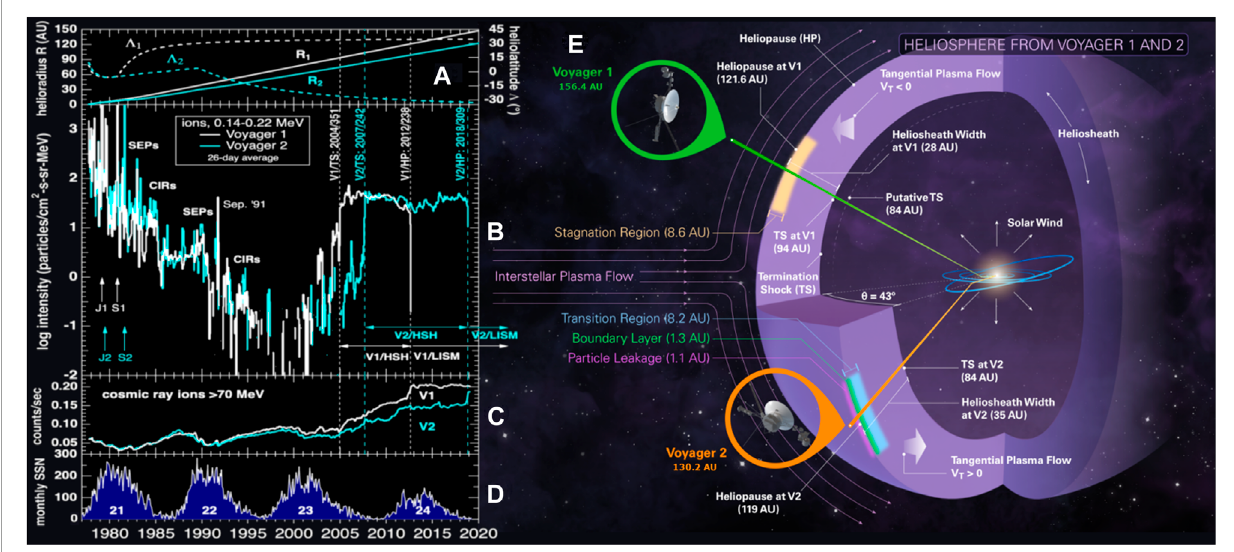
FIGURE 1 (A) The trajectories of V1 and V2 since their launch in 1977, through interplanetary space, the termination shock and heliopause until 2020, together with the LECP measurements of (B) 0.14–0.22 MeV ions and (C) > 70 MeV Galactic Cosmic Rays (GCR), that correspond to (D) four full solar cycles (from Dialynas et al. (2022b)). (E) A Concept of the global heliosphere summarizing the findings of V1 and V2 (From Krimigis et al.